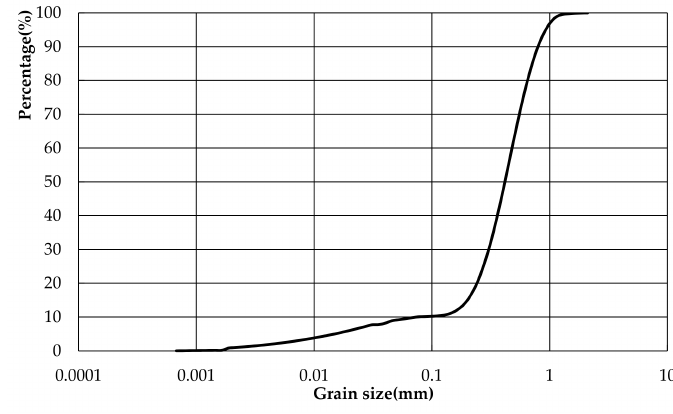
Figure 2. Sediment grading